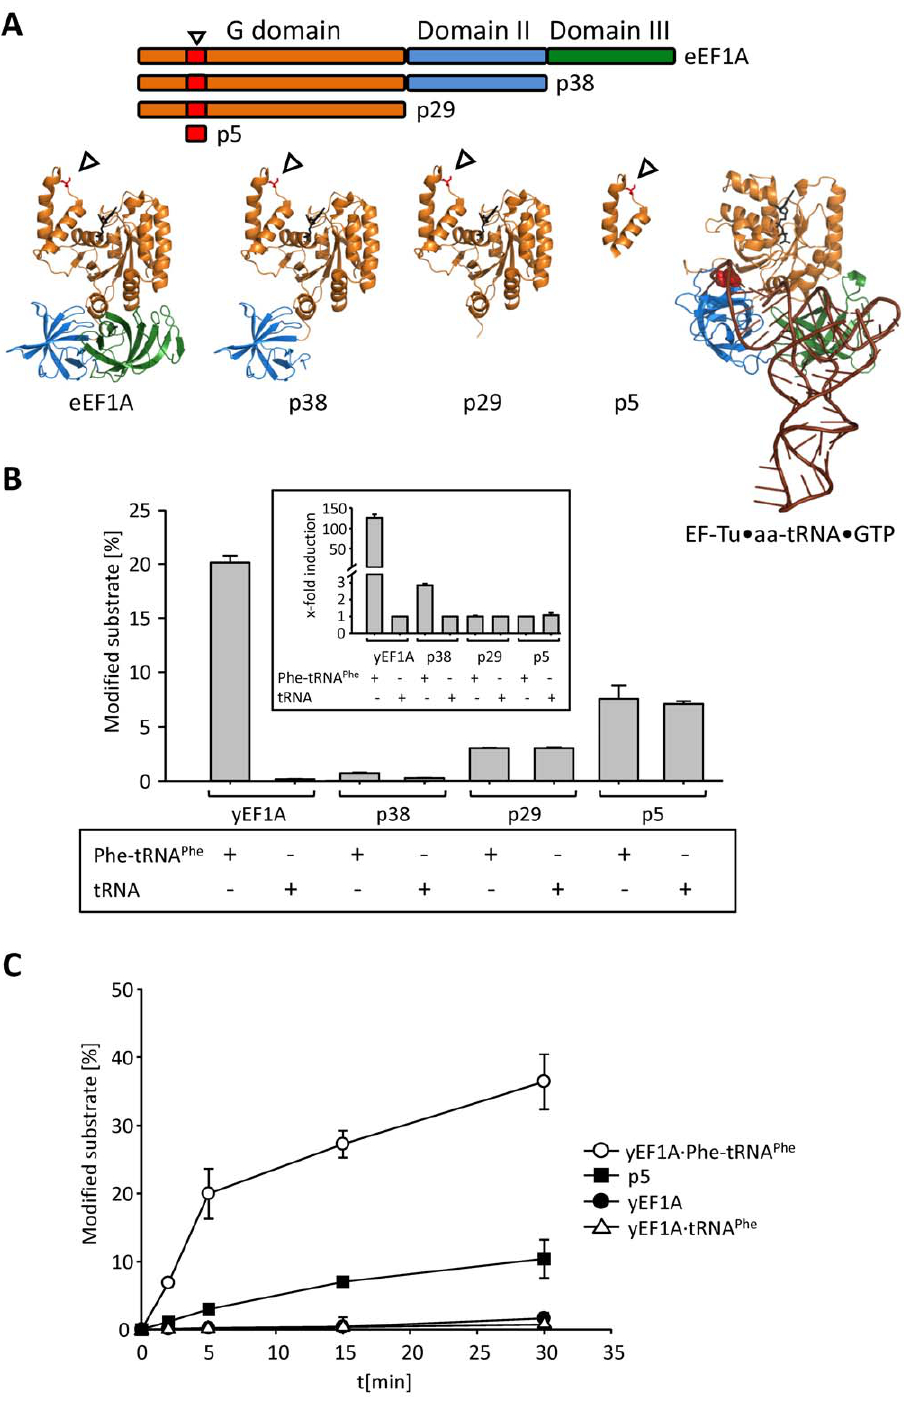
Figure 5. Models of eEF1A constructs and activity of Lgt’s in glucosylation of eEF1A fragments. (A) Schematic representation of the eEF1A truncations used (upper panel). Lower panel: Structural models deduced from the crystal structure of eEF1A in complex with eEF1B (pdb 1IJF). For visualization of the region of aminoacyl-tRNA binding the crystal structure of the ternary complex of EF-Tu N GTP N Phe-tRNA Phe (pdb 1TTT) is depicted on the right. The GTPase domain (G domain) is shaded in orange, domain II in blue, domain III in green, and tRNA is shown in brown. The aminoacyl residue of aa-tRNA located between the G domain and domain II is shown as red spheres. GDP or GTP is depicted as black sticks. The position of glucosyl acceptor serine 53 is shown in red and marked with arrowheads. The figures were prepared using PyMOL (www.pymol.org). (B) Glucosylation of different truncation fragments of yeast eEF1A (yEF1A) (3 m M) was performed with Lgt3 (140 nM) in the presence of Phe-tRNA Phe or uncharged tRNA Phe (each 1 m M), respectively. Constructs used: p38 represent eEF1A without domain III (aa1-349), p29 harbors the G domain (aa1- 265), and p5 is a 5 kDa-peptide, comprising the helix-loop-helix region (aa29-73) of yEF1A. Glucosylation was performed under standard conditions for 15 min at 30 u C. The insert shows the induction of Lgt3-catalyzed glucosylation of the fragments by Phe-tRNA Phe . (C) Time courses of in vitro glucosylation of yEF1A in complex with GTP and Phe-tRNA Phe (open circles), the 45 amino acid fragment of yEF1A p5 (filled squares), yEF1A (filled circles), and yEF1A with uncharged tRNA Phe (open triangles) by Lgt3. All data given represent means ( 6 SD) of three independent experiments. doi:10.1371/journal.pone.0029525.g005 PLoS ONE |